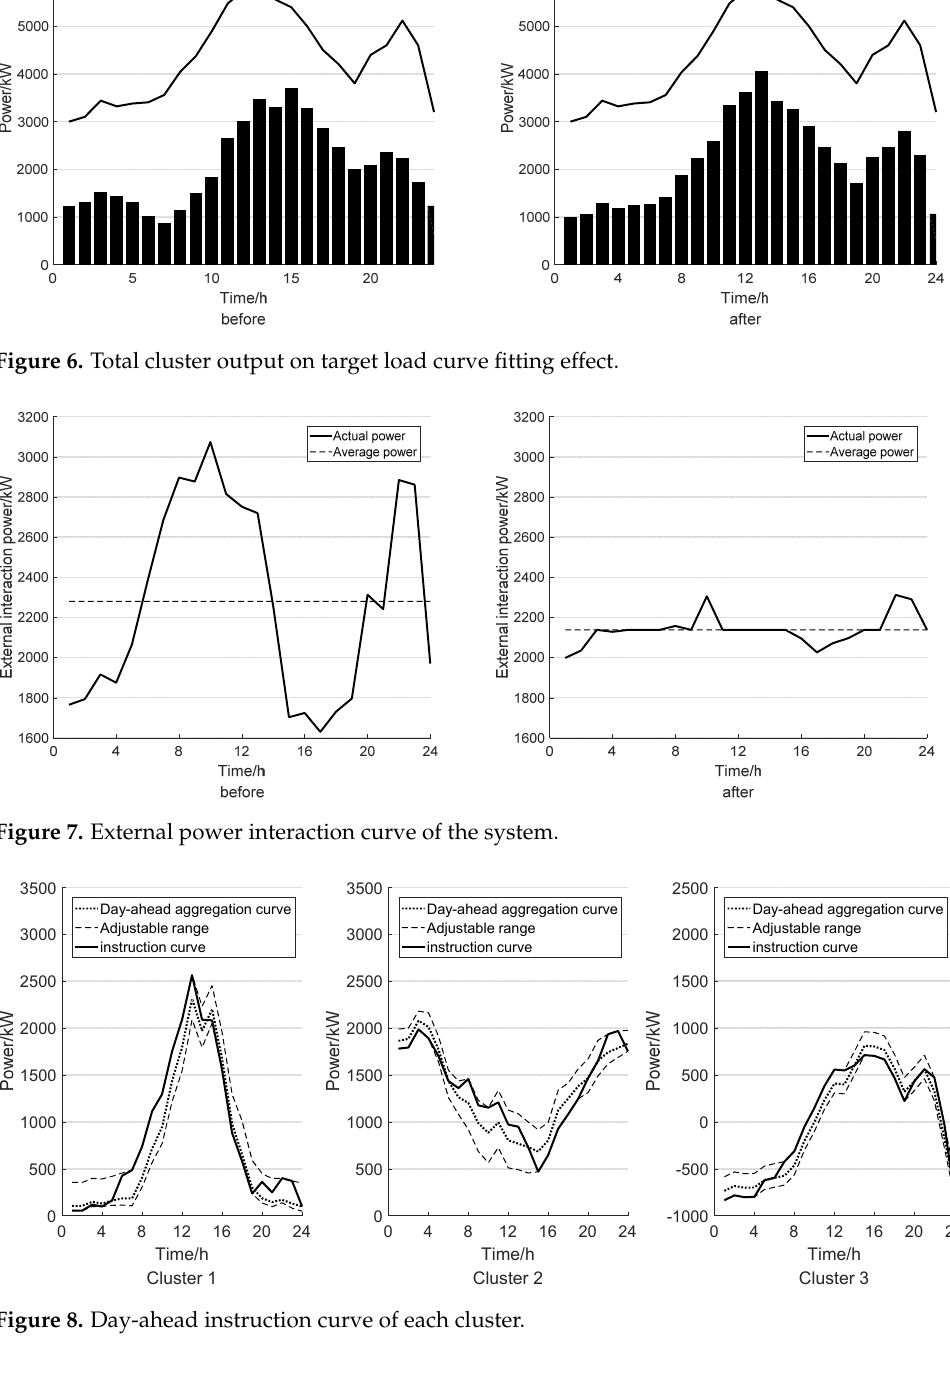
Figure 8. Day ‐ ahead instruction curve of each cluster. Figure 8. Day-ahead instruction curve of each Table 2. Electricity trading cost.